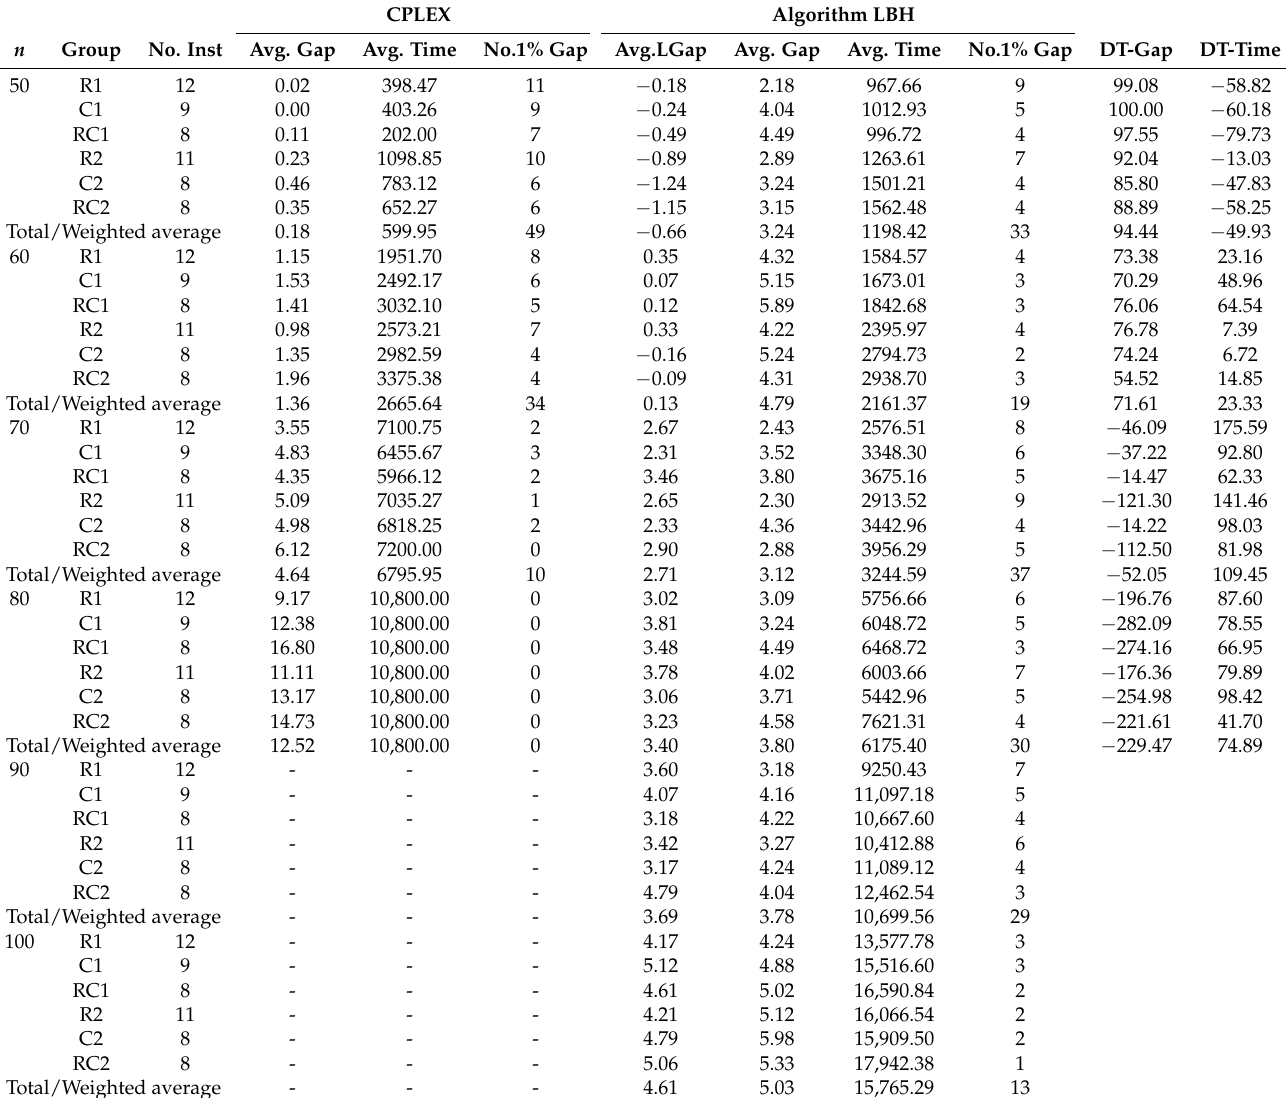
Table 3. Algorithmic performance